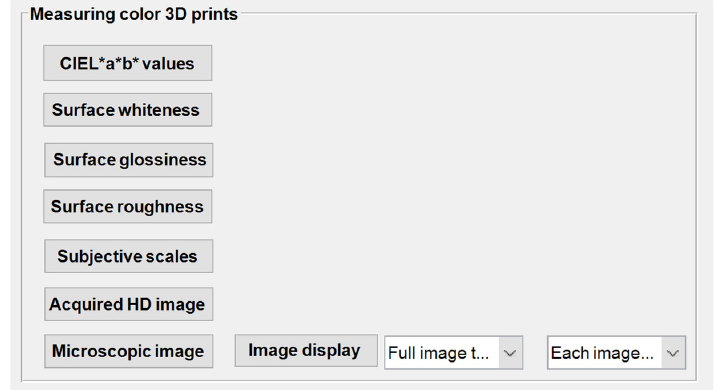
Figure 11. Initial interface of Module 2. Table 2. Types, labels, and roles of the controls used in the Module 2 interface.